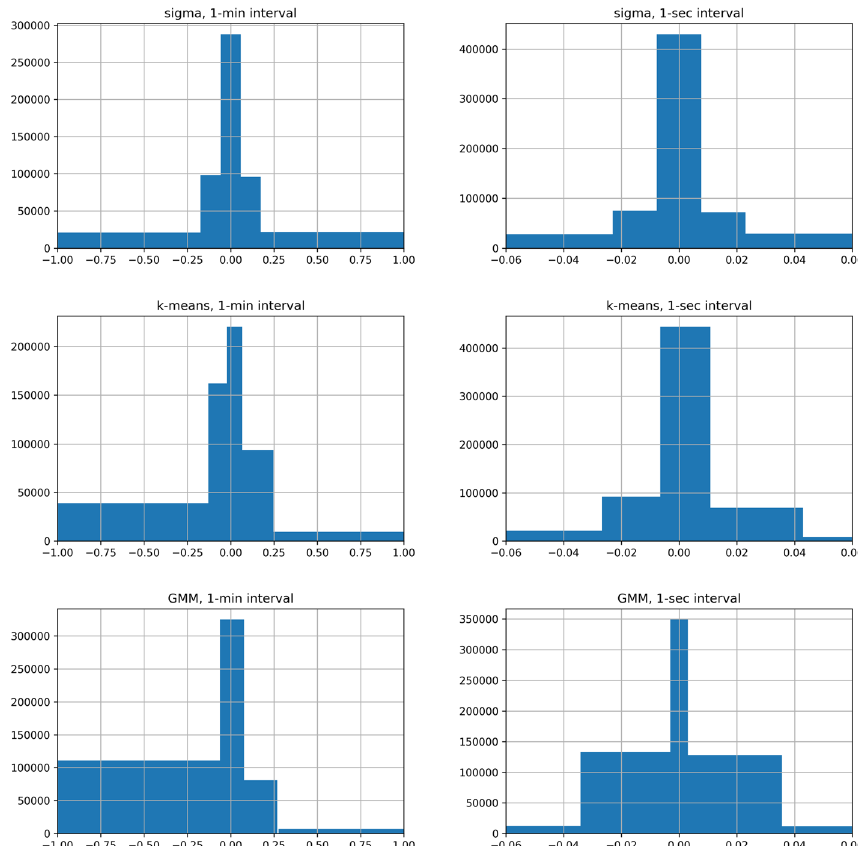
Fig. 2 Sigma (top), k-means (mid) and GMM (bottom) discretizations of the percentage 1-min (left) and 1-s (right) returns